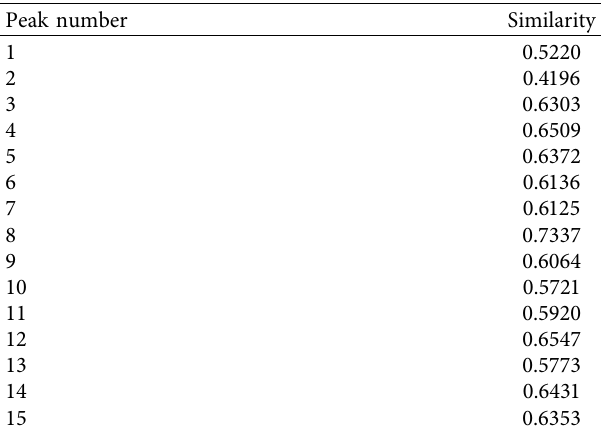
Table 7: Grey correlation between the common peaks of flavonoids from Glycyrrhiza uralensis Fisch. and foot swelling test.